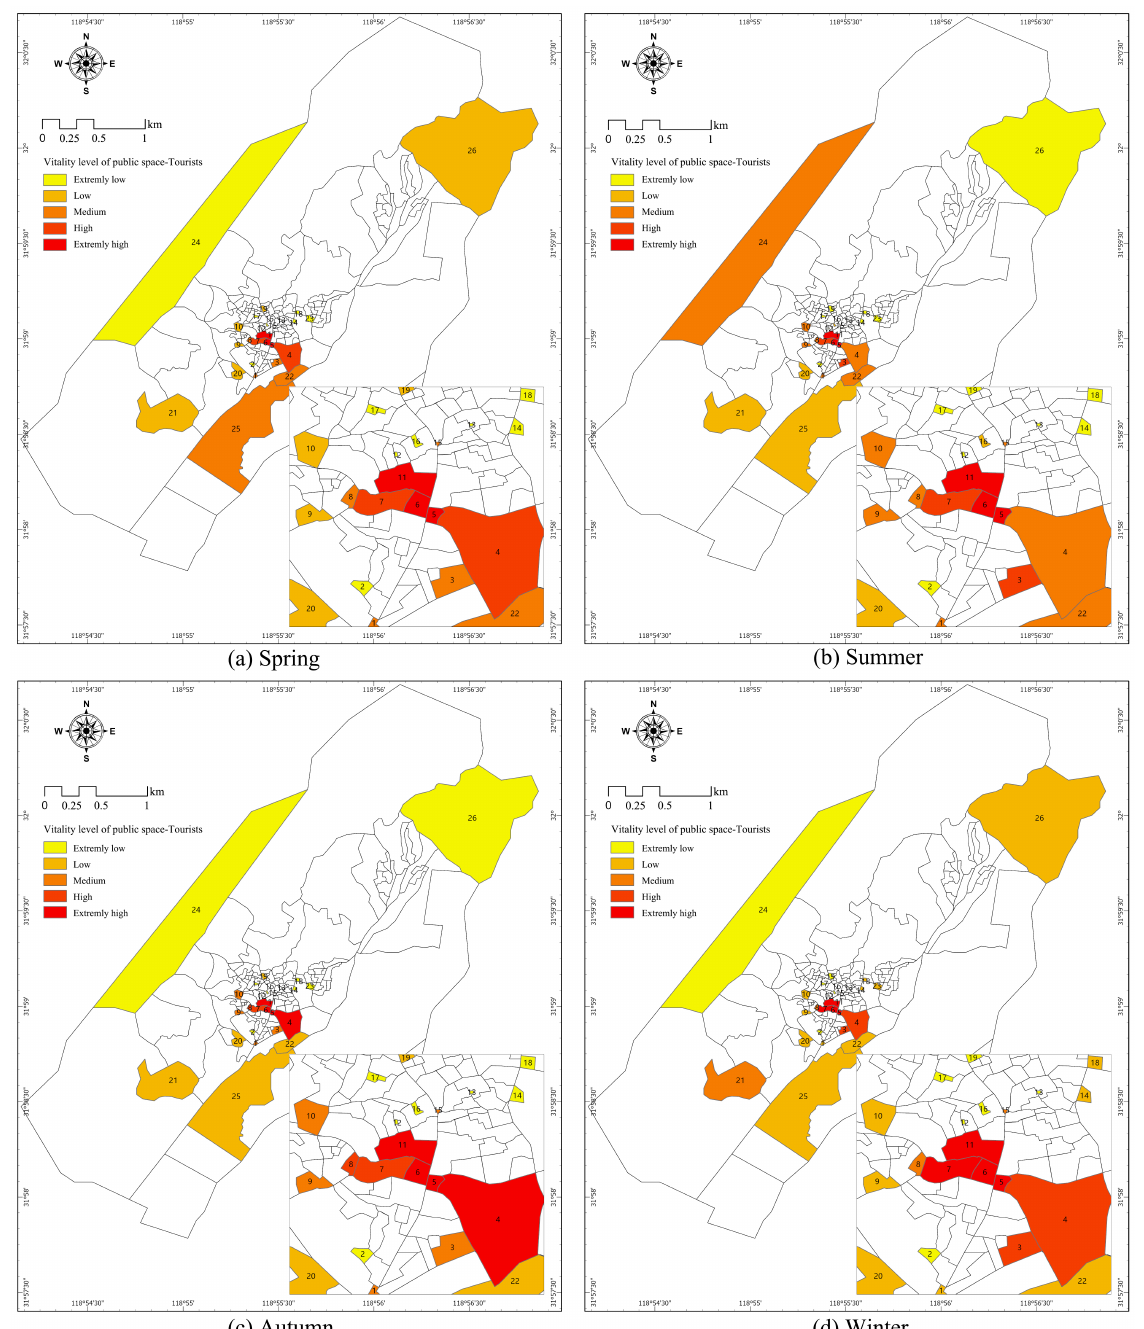
Figure 5. . Figure 5. Four Seasons Public Space